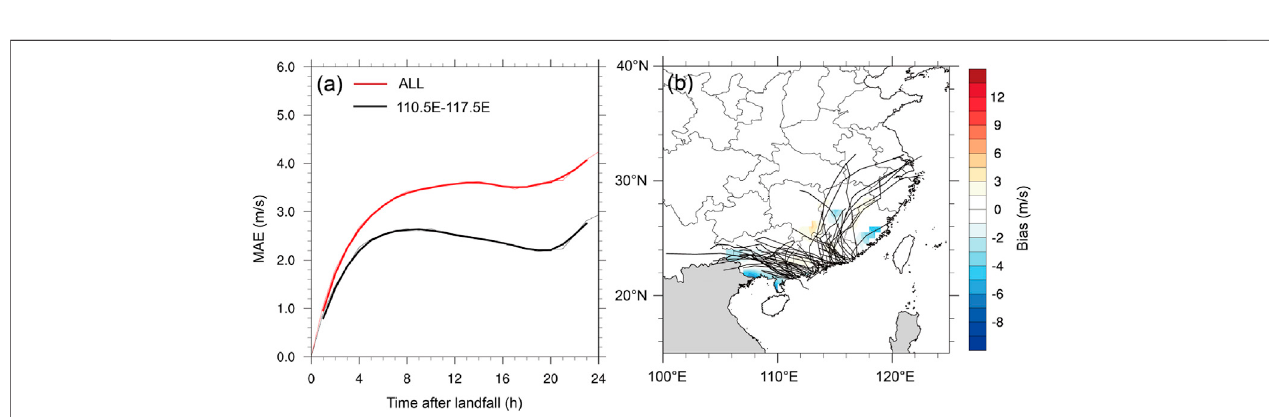
FIGURE8 | The mean decay curves ofmaximum sustained near-surface wind (m s − 1 ) (A) forall samplesof landfalling TCs, and (B) for TCs making landfallnorthof 29 ° Nover China. Distributionof (C) MAE (m s − 1 ) and (D) biases (m s − 1 ) ofall samplesoflandfallingTCs(red lines)and TCs making landfall north of29 ° N(black lines)over China during 1980 – 2018.